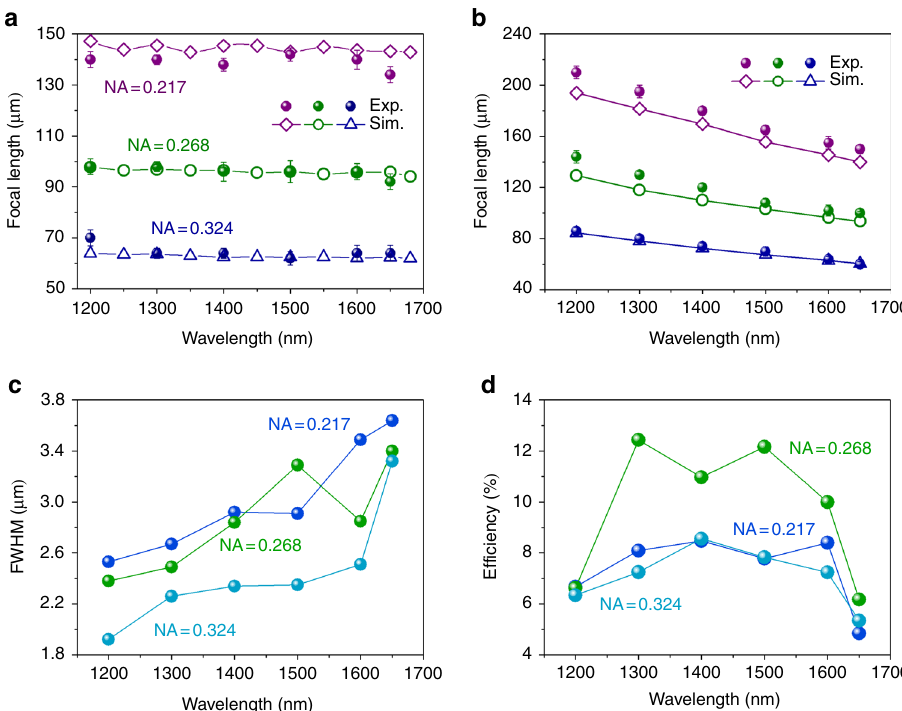
Fig. 4 Performance of broadband achromatic metalens. Measured and simulated focal length of a BAML with various NA values and b chromatic metalenses. Measured c FWHM and d operation ef fi ciency at corresponding focal plane as a function of wavelength. The ef fi ciency is de fi ned as the ratio of light intensity from the focal spot at corresponding focal plane to the light intensity re fl ected by a metallic mirror with the same pixel sizes. The error bars present the length of distance from the focal plane where the intensity of focal spot remains the maximum value in